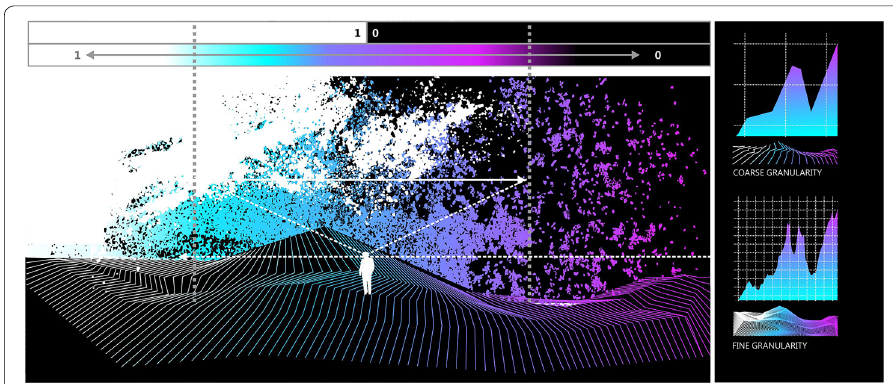
Fig. 7 Immersive Analytics Principle 4: representations tuned to intermediate zone where human perception is most